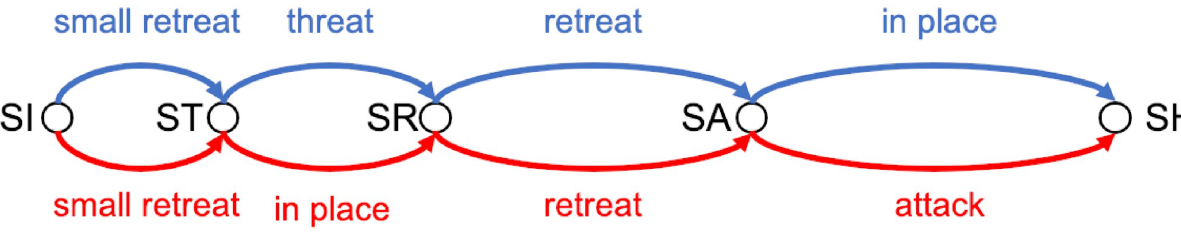
Fig 6. Motion scheme of the frontal spaces. The analysis of the mutual distance leads to a transition system for Steffen (red) and Grumier (blue). Each arrow represents a transition between two states realized by a frontal space.